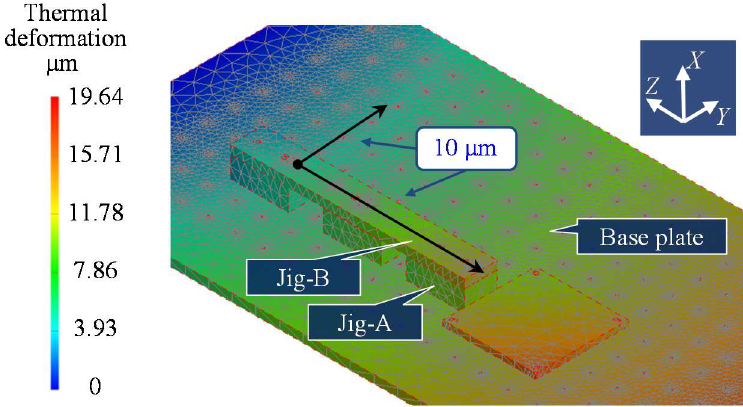
Figure 10. Thermal expansion of each component estimated in the simulation based on a finite element model.